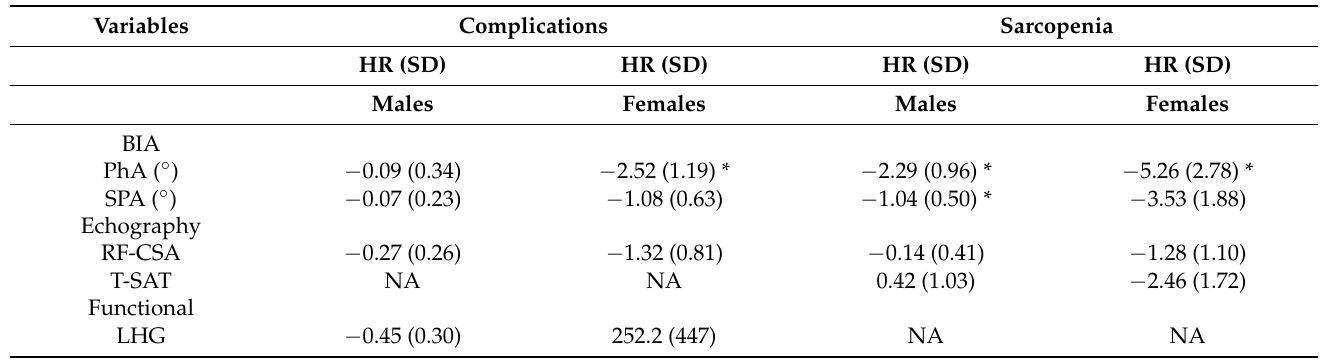
Table 3. Multiple regression analysis of phase angle as a predictor of complications and sarcopenia in colorectal cancer